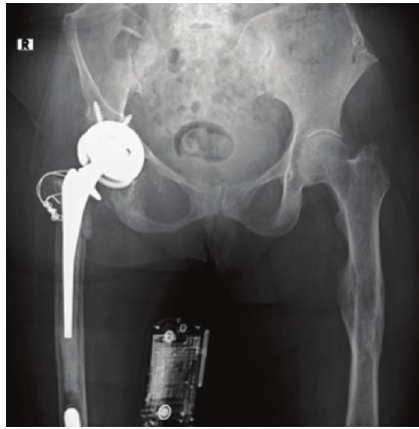
Figure 11: 8 months after